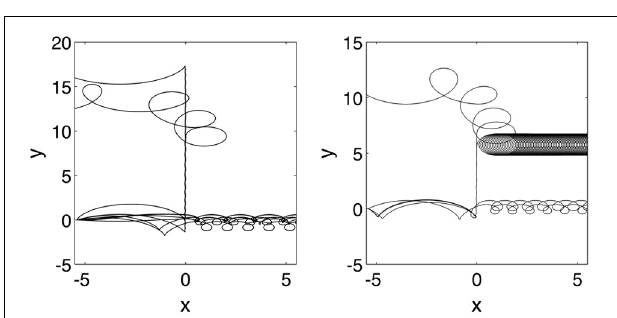
FIGURE 11 | Left: Initial vs. final energy. Right: orbits of several pre-accelerated ions. For the shock with θ = 80 ◦ , s = 0 . 5, and D = 0 . 1, and v p =